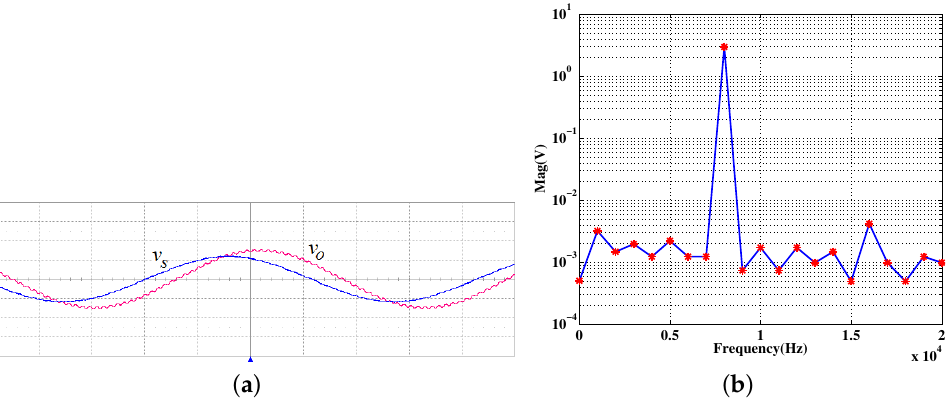
Figure 15. ( a ) v s and v o waveforms at 8 kHz: v o (1 volt/div), v s (0.1 volt/div), timescale: (50 micro- second/div) ( b ) frequency spectrum of 8 kHz output